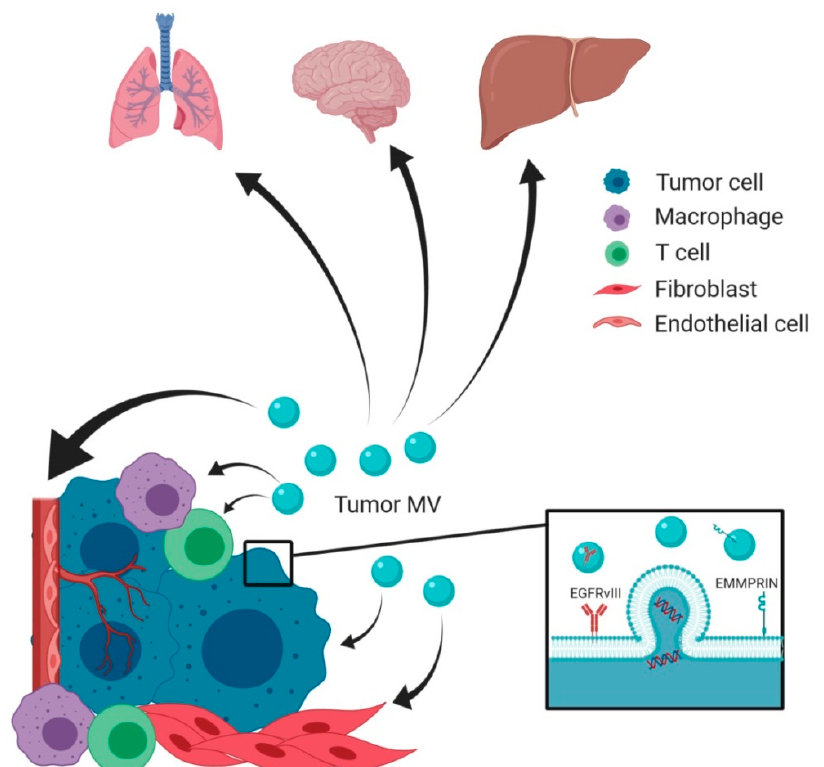
Figure 1. Microvesicles (MV) shaping the local tumor microenvironment (TME) and distant metastatic niches to promote tumor growth. On the one hand, MV shed from the plasma membrane of tumor cells act in an autologous way on other tumor cells by transferring oncogenic cargo and stimulating pro-tumorigenic signaling. On the other hand, MV are able to mediate heterologous cell–cell communication by acting on cells present within the TME, such as macrophages, T cells, fibroblasts, or endothelial cells. As a result, these cells become activated and change their phenotype to enhance tumor growth. Once the tumor has gained access to the circulation, tumor MV can be distributed throughout the body and mediate cargo transfer and cell–cell communication at distant sites. This induces the formation of pre-metastatic niches that offer a favorable environment for subsequent seeding of tumor cells in secondary organs.